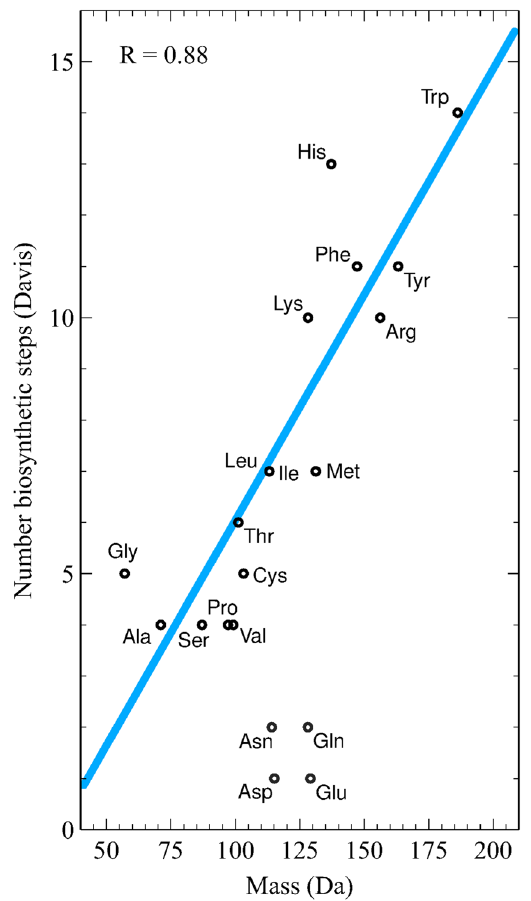
Figure 4. Correlation between the molecular mass of the amino acids M X and their energetic cost as accounted by the number of biosynthetic steps B X proposed by Davis 37 . The outliers {Asn, Asp, Gln, Glu} are excluded from the Pearson’s correlation and from the linear